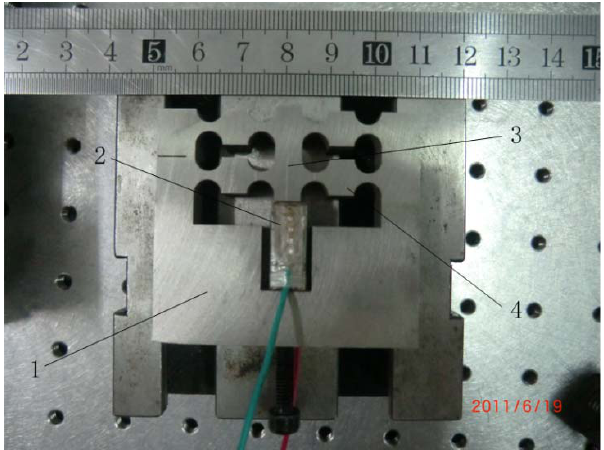
Figure 5. Photographic of the FTS